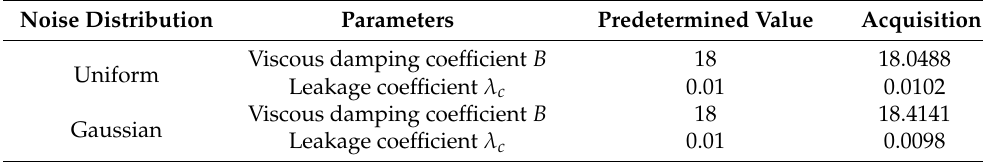
Figure 14. The episode training process of viscous damping coefficient and leakage coefficient subject to noise of Gaussian distribution. Table 5. The results of the viscous damping coefficient and the leakage coefficient concurrently.